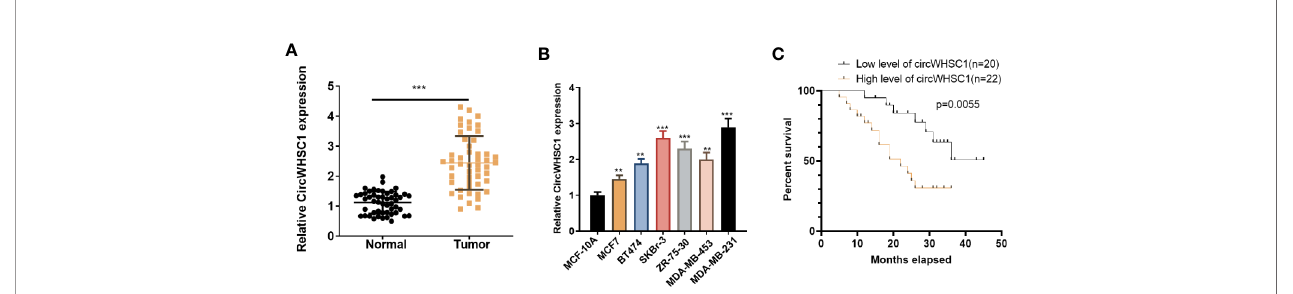
FIGURE 1 | CircWHSC1 expression in non-tumor and cancer tissues. (A) : qRT-PCR assessed circWHSC1 pro fi le in tumors and paired non-tumor tissues of BC patients. *** P < 0.001 (vs. Normal group). (B) qRT-PCR was adopted to measure the circWHSC1 pro fi le in normal breast epithelial cells MCF-10A and BC cell lines (MCF7, BT474, SKBr-3, ZR-75-30, MDA-MB-453, and MDA-MB-231). ** P < 0.01, *** P < 0.001 (vs. MCF-10A group). (C) Kaplan-Meier assay was used for analyzing the overall survival of BC with high or low levels of